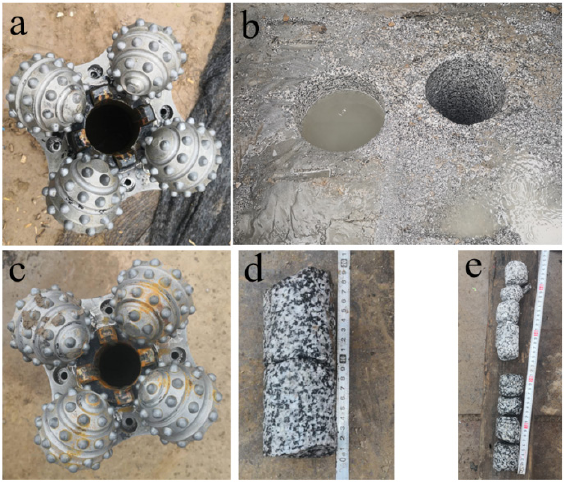
Figure 3. Test photos of roller core bit: ( a ) Photos of drill bit before test; ( b ) Drill bit wear after test; ( c ) Drilling into holes during the test; ( d , e ) Obtained core samples.